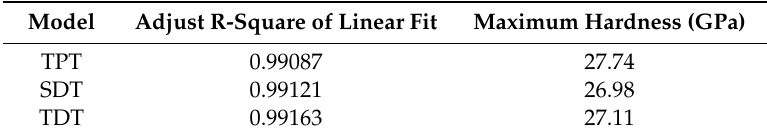
Table 1. Adjust R-Squares of three linear fits and critical hardness of three models.